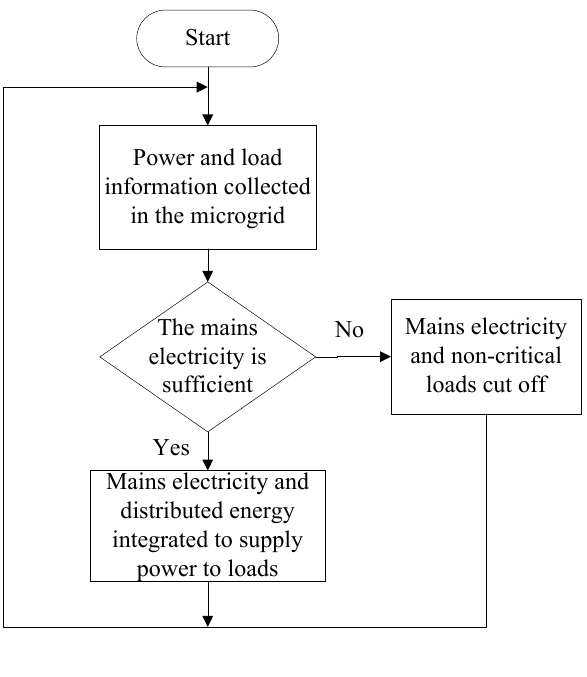
Figure 15. Flowchart of the distributed energy integrated with mains electricity as the primary power supply mode